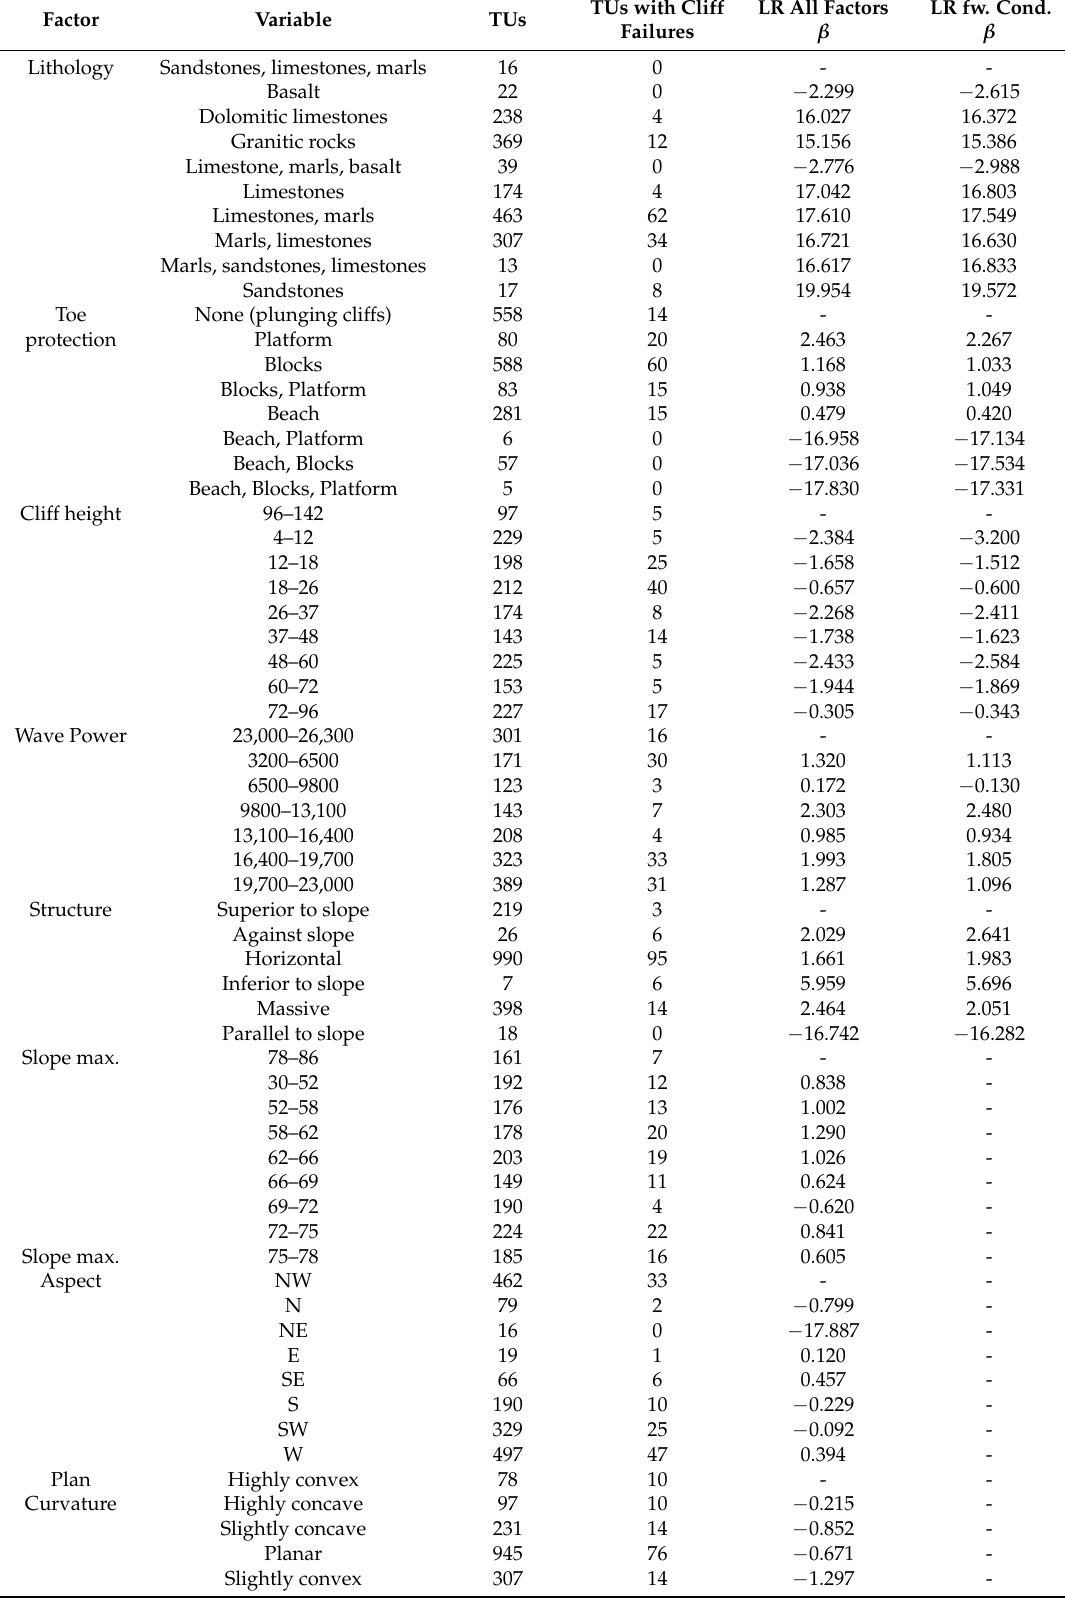
Table 2. Variable classification of factors with number of terrain units (TU), terrain units with cliff failures and Logistic Regression constant ε and β